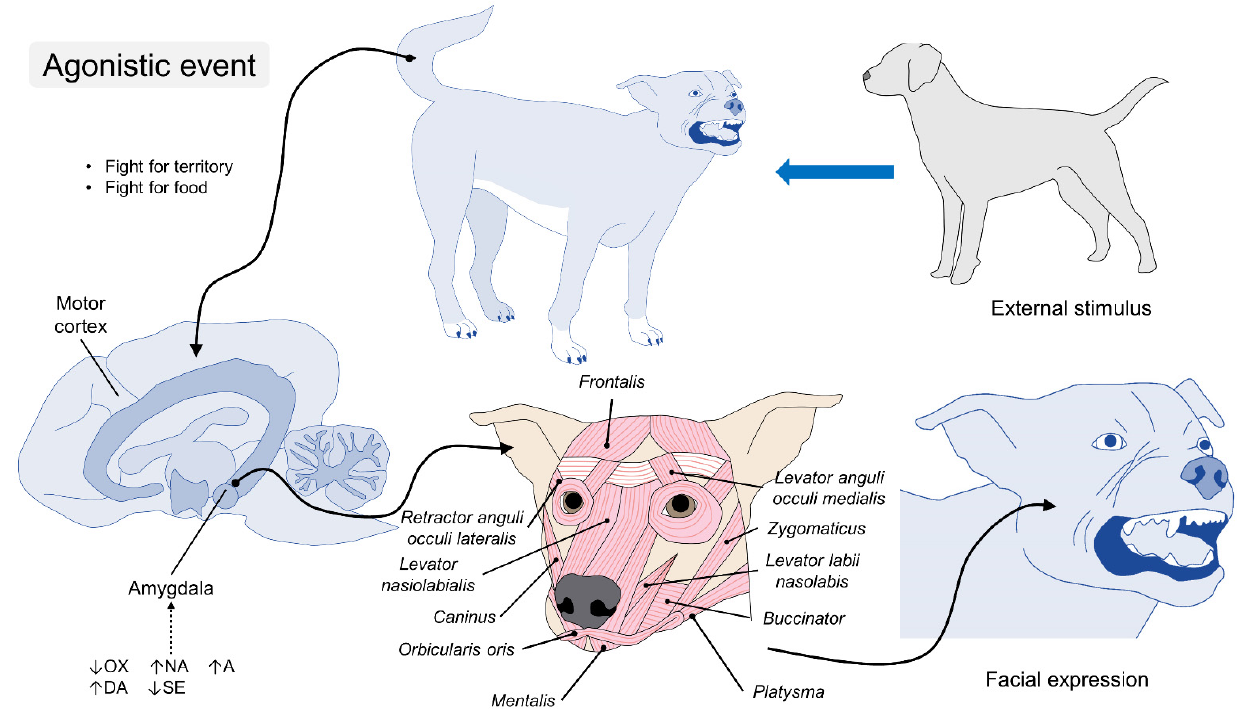
Figure 7. Facial expressions represent aggression. The perception of an adverse external stimulus (e.g., a person or another animal) triggers a neuroendocrine response with an elevation in catecholamine levels, together with a decrease in circulating levels of OXT, DA, and SE. When this negative emotion is recognized in the amygdala, its connections to the motor cortex and facial muscles (trough the facial nerve) cause the flattening of the ears (EAD105), lifting of the upper lip to bare their teeth (AU116), nostril opening (AD38), more visible white sclera (AU101), and vocalizations (AU34) as a sign of threat. OXT: oxytocin; NA: noradrenaline; A: adrenaline; DA: dopamine; SE: serotonin.